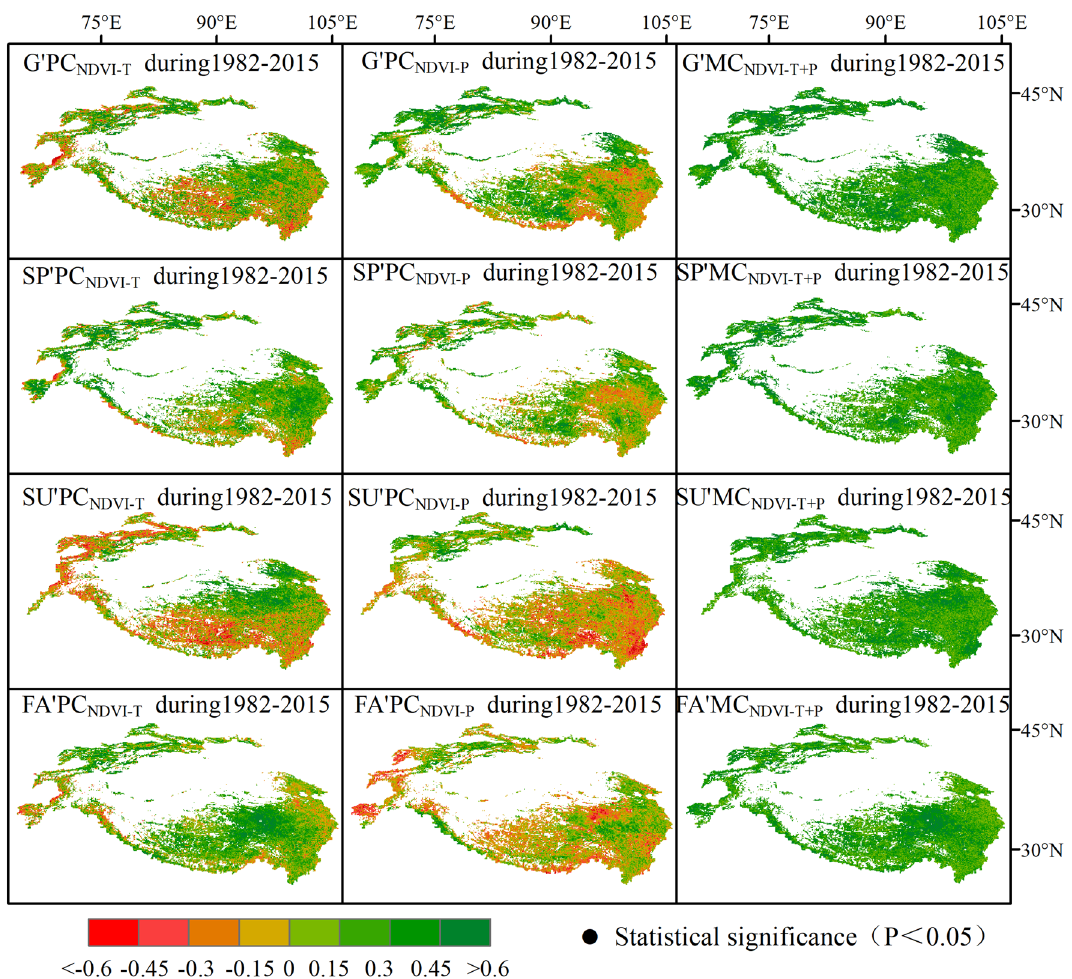
Figure 4. Spatial distribution of inter-annual partial correlation coefficients between NDVI and precipitation (PC NDVI-P ) and temperature (PC NDVI-T ) and multiple correlations between NDVI, temperature and precipitation (MC NDVI−T+P ) for growing seasons (G), i.e. spring (SP), summer (SU) and fall (FA), during 2000–2018 in HMA. Note that regions with black dots indicate that partial correlation and multiple correlation coefficients are statistically significant (p < 0.05) (Generated by ArcGIS 10.3, URL: http:// www. esri. com/ softw are/ arcgis/ arcgis- for- deskt